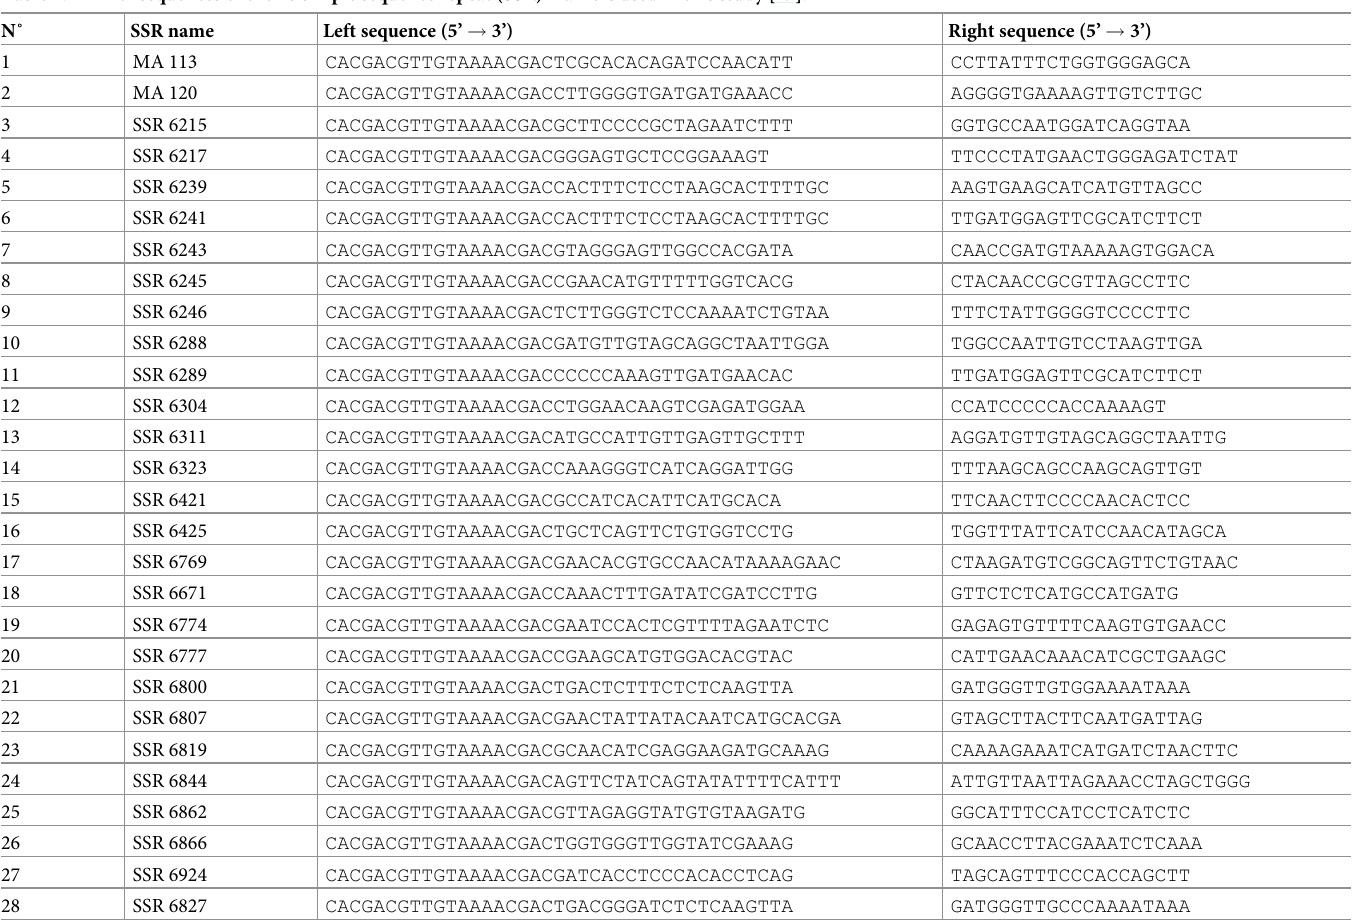
Table 2. Primer sequences of the 28 simple sequence repeat (SSR) markers used in this study